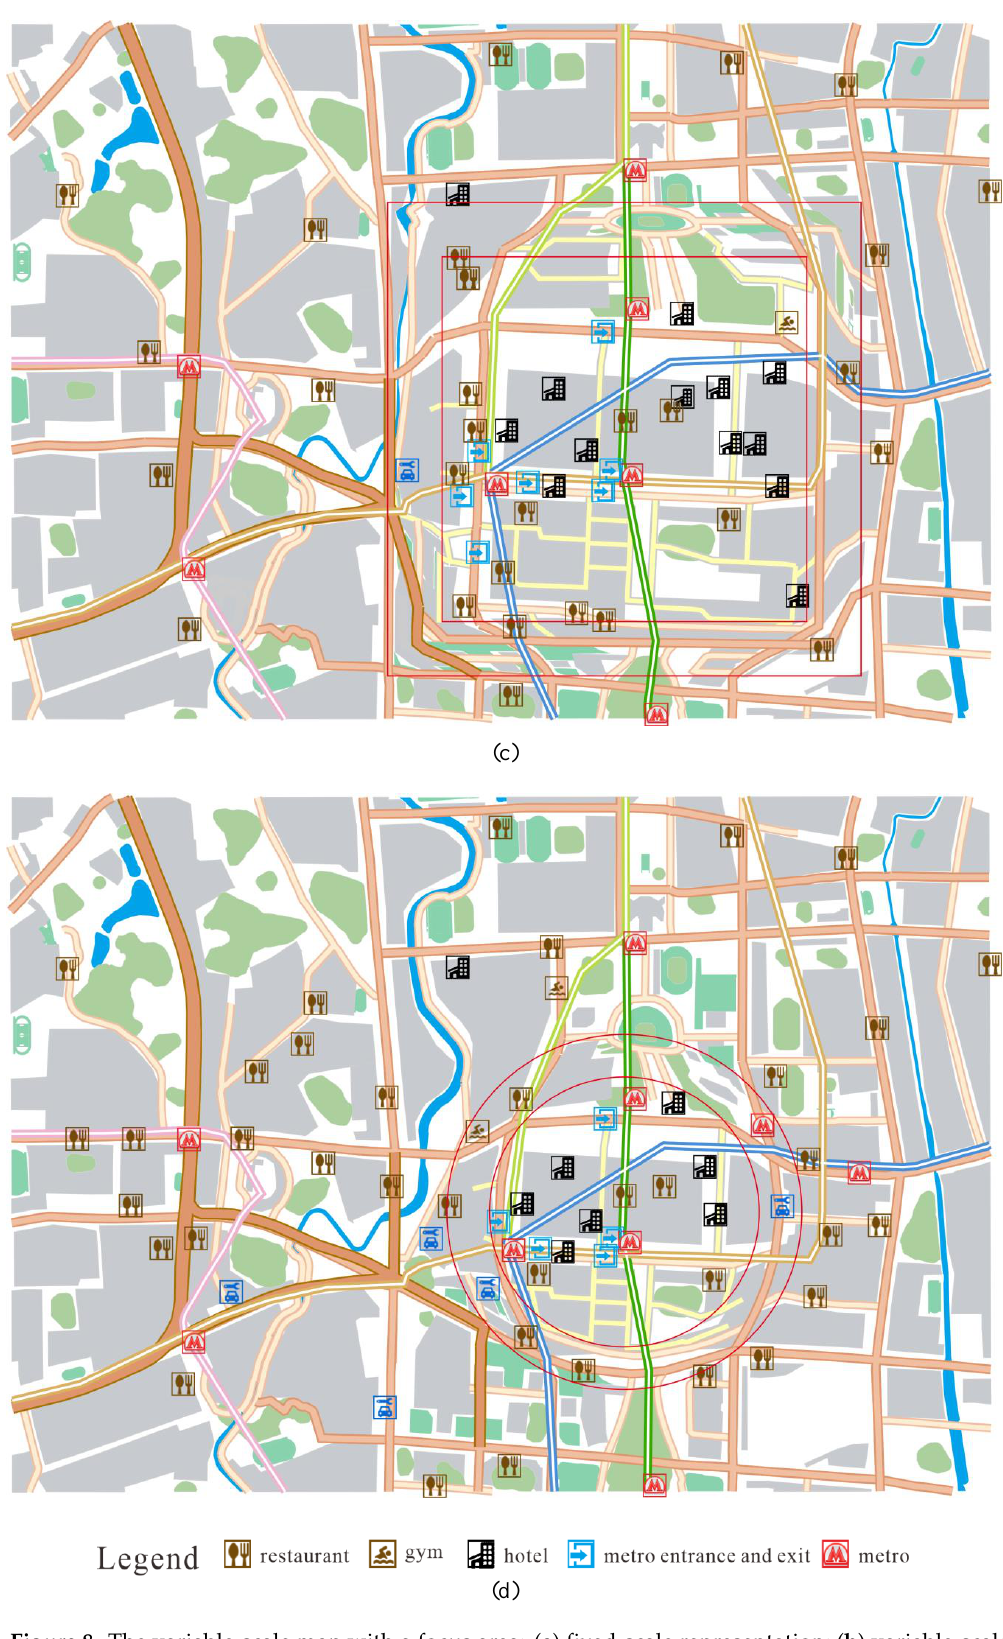
Figure 8. The variable-scale map with a focus area: ( a ) fixed-scale representation; ( b ) variable-scale representation and the shape of the focus area is a circle; ( c ) variable-scale representation and the size of the focus area is smaller; ( d ) variable-scale representation and the shape of the focus area is